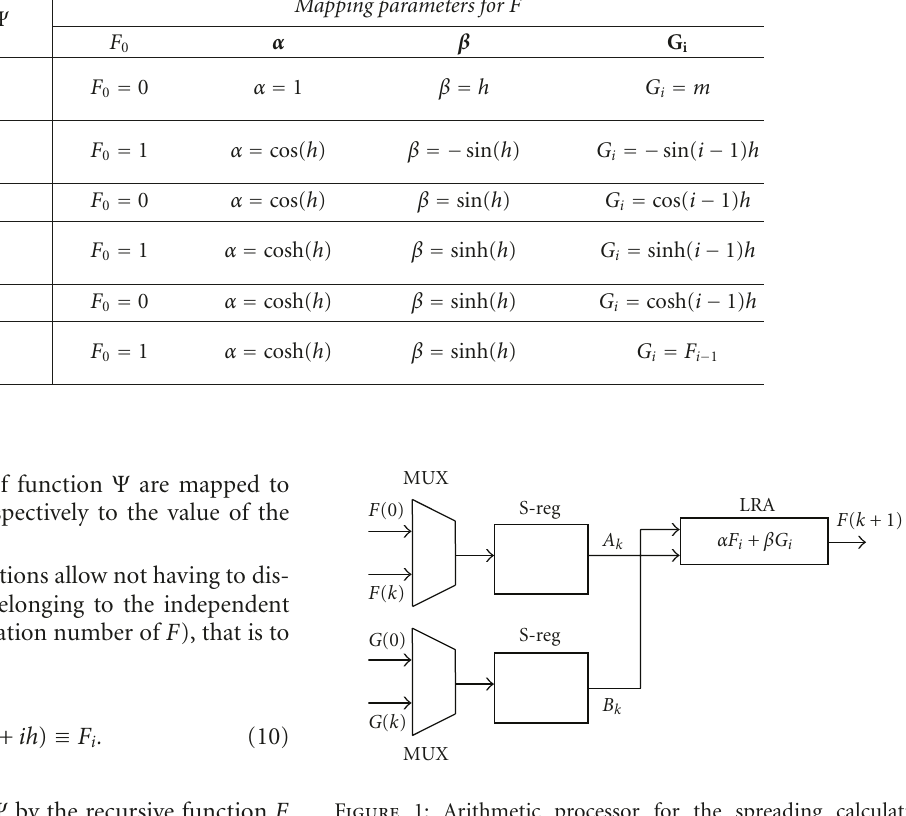
Figure 1: Arithmetic processor for the spreading calculation scheme.